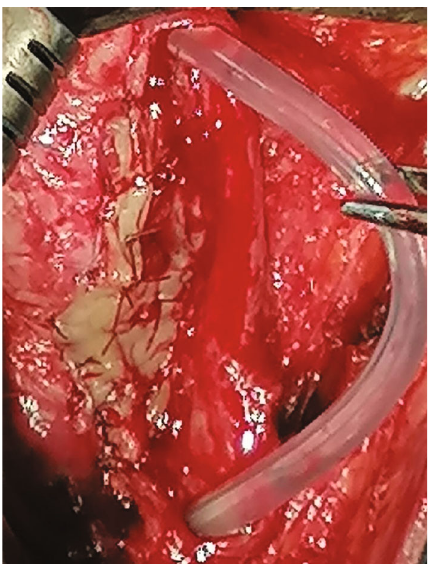
Figure 7: Suturing the left edge to the urethral plate to the left lateral aspect of the